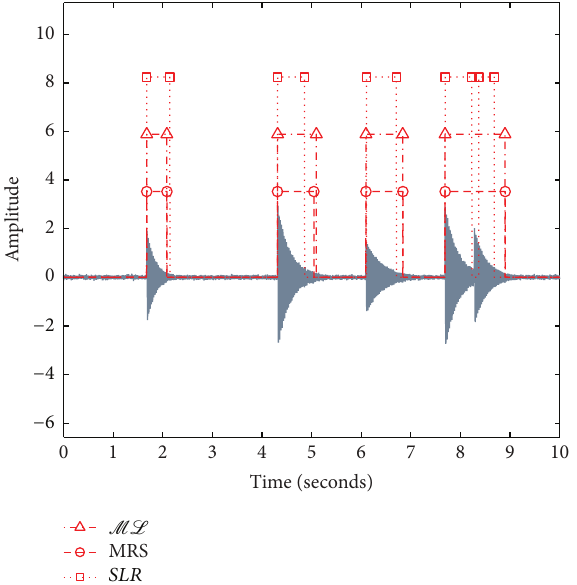
Figure 8: The comparison of segments produced by different methods applied to the simulated multievents dataset.